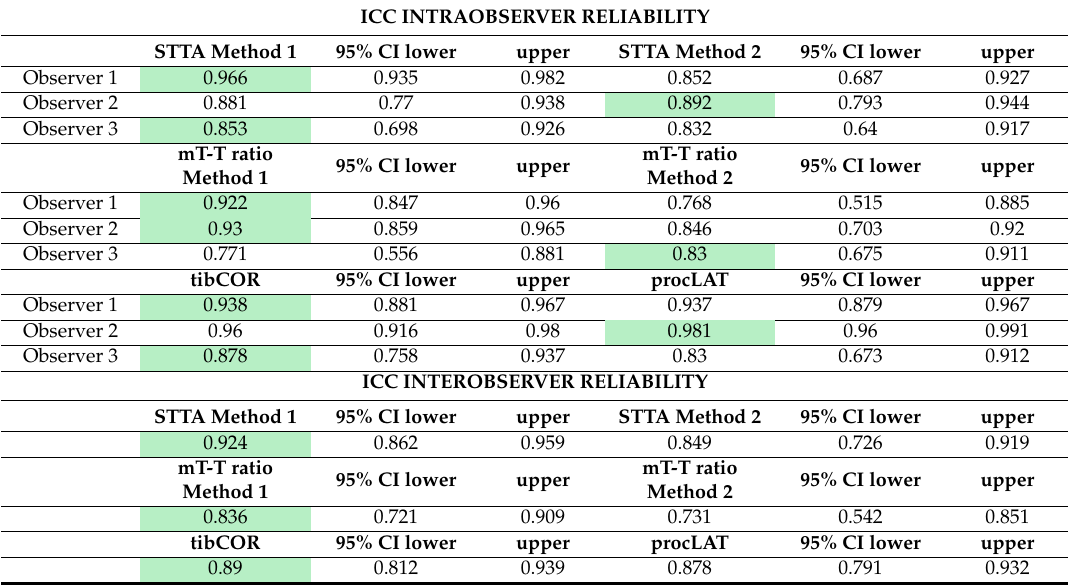
Table 1. Intra- and interobserver reliability.